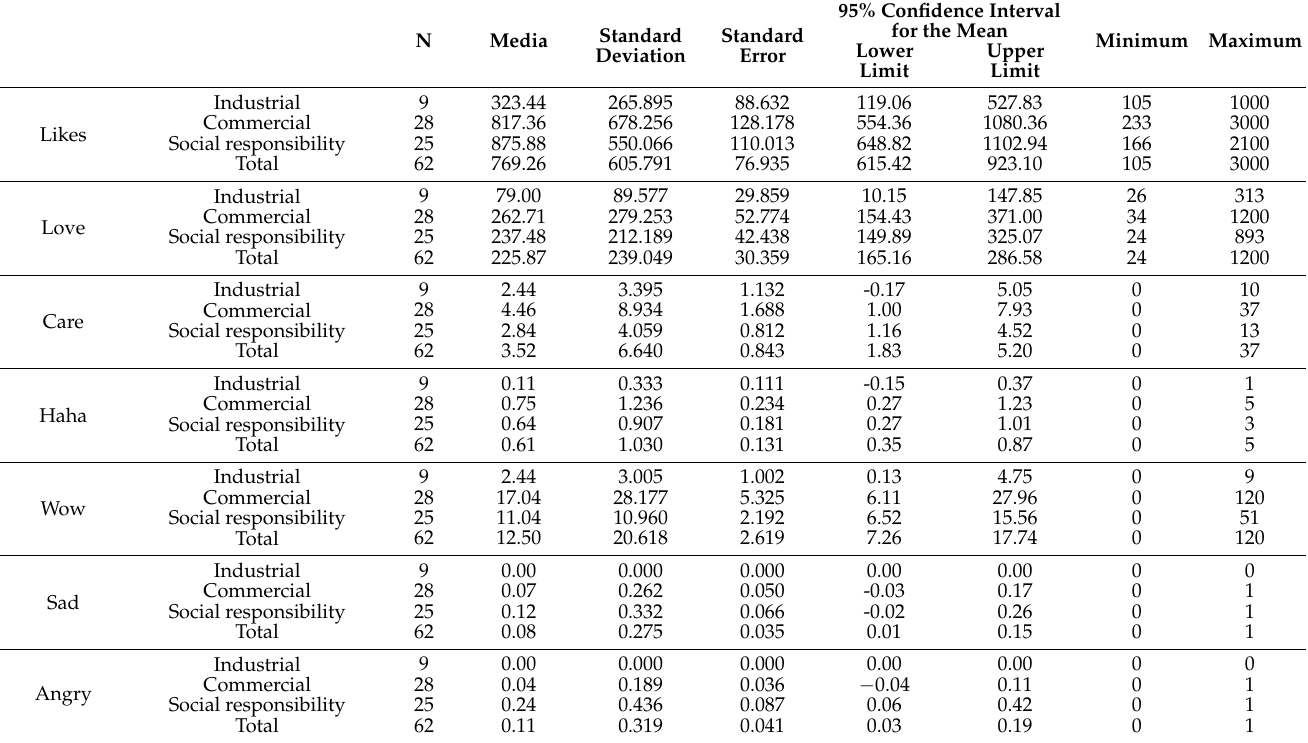
Table 5. Descriptive statistics of feelings according to brand